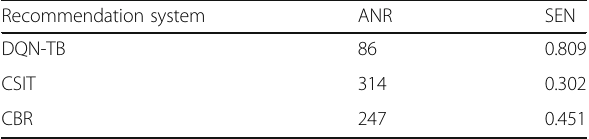
Table 3 Response sensitivity of each recommendation system Recommendation